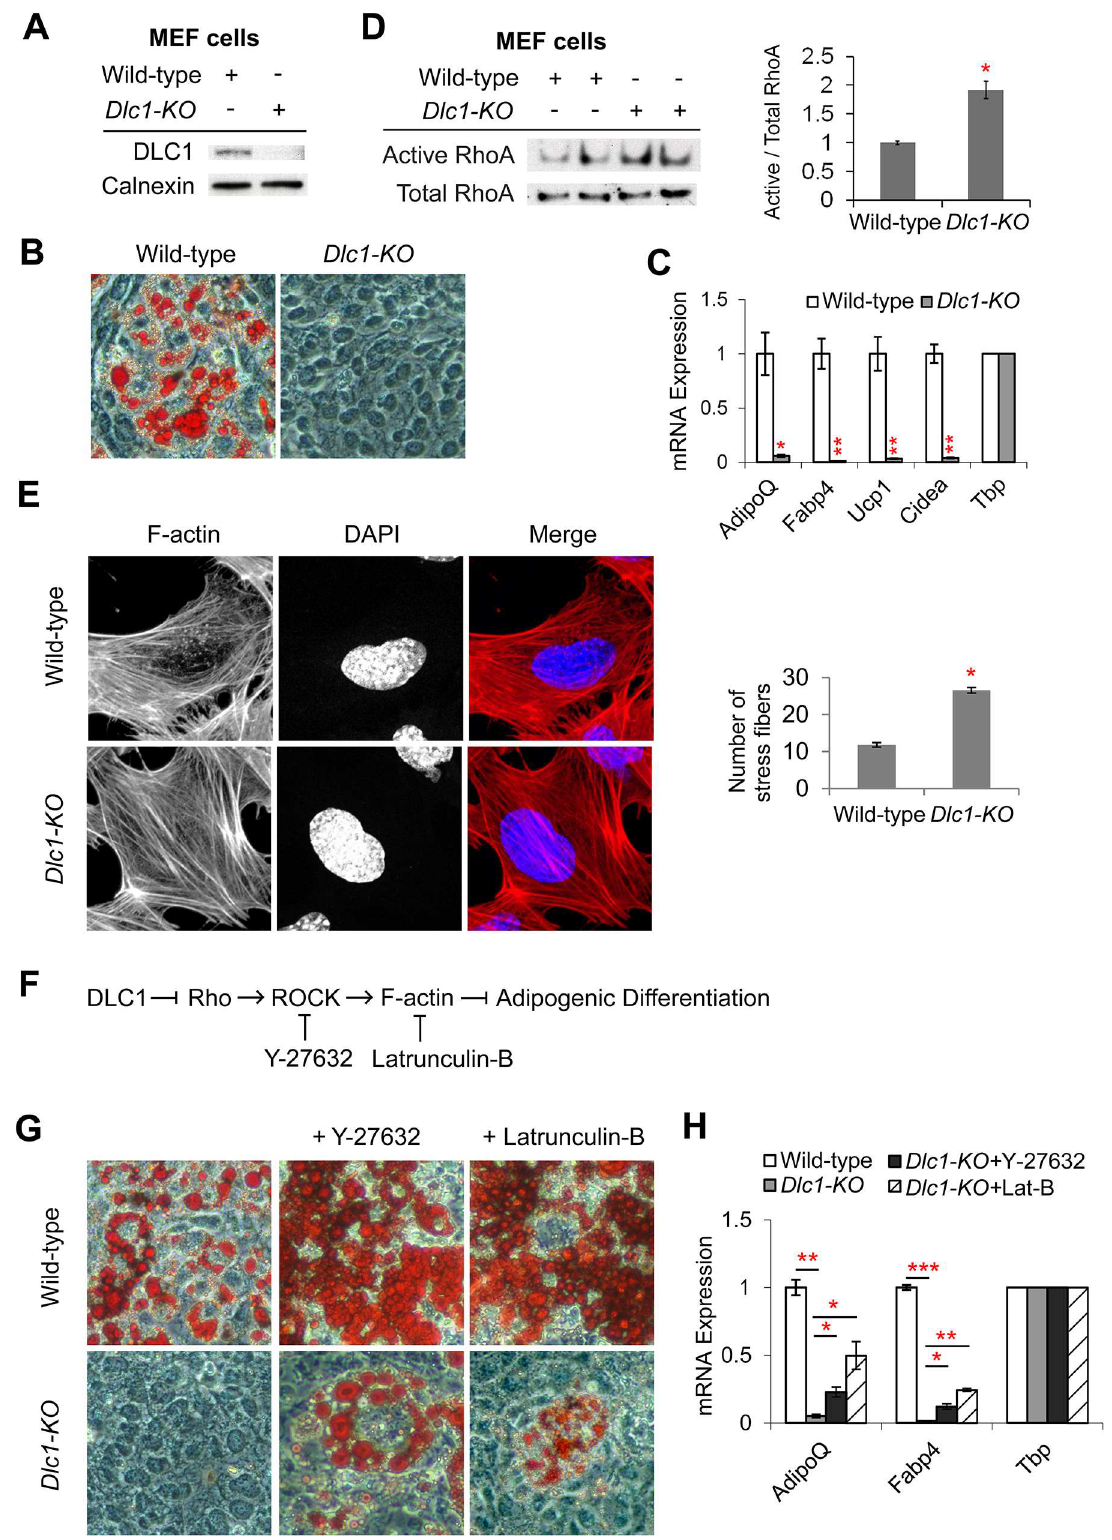
Fig 4. Adipogenic Role of DLC1 Involves the Rho Pathway. (A) Western blots showingthe absenceof DLC1 protein in Dlc1-KO MEFs. Calnexinwas includedas a loadingcontrol. (B) Oil-Red-O stainingof differentiatedwild-typeand Dlc1-KO